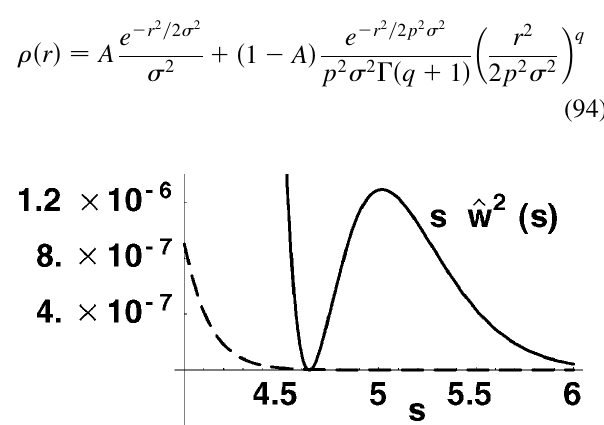
FIG. 14. Zoom up of Fig. 13 that shows a node in the position density distribution at s (cid:21) 4 : 7